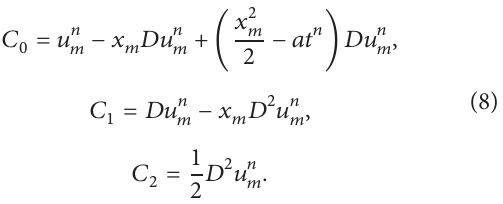
Figure 1: Once a specific solution that embeds three points 𝑝 1 , 𝑝 2, and 𝑝 3 is found, an approximated point 𝑝 4 can be obtained from the